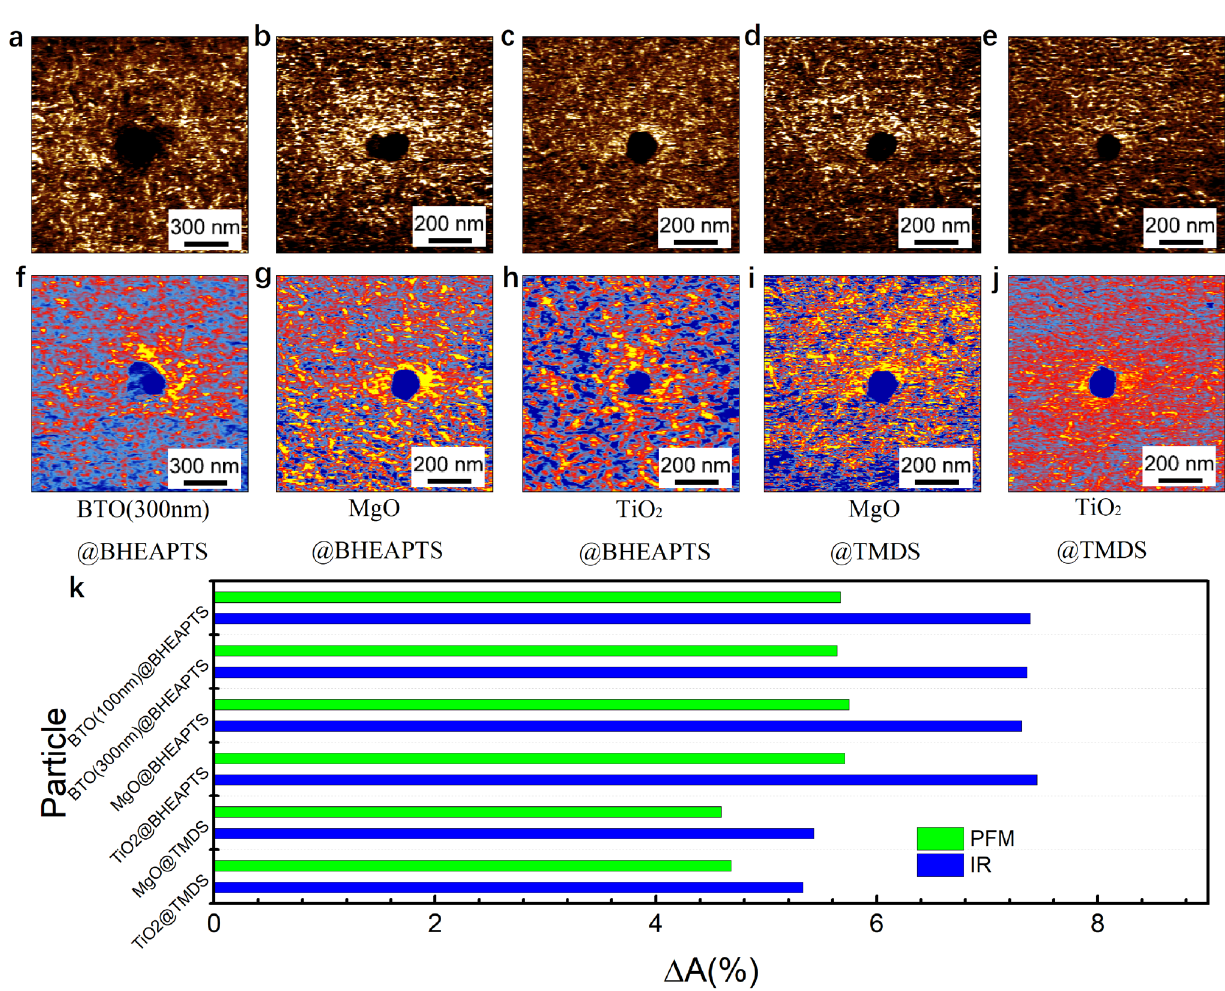
Fig. 4 a – e PFM mappings and f – j Nano-IR mappings at 1288 cm −1 of samples with different particles modified by BHEAPTS and TMDS. k Δ A PFM and Δ A IR of samples with different particles modified by different